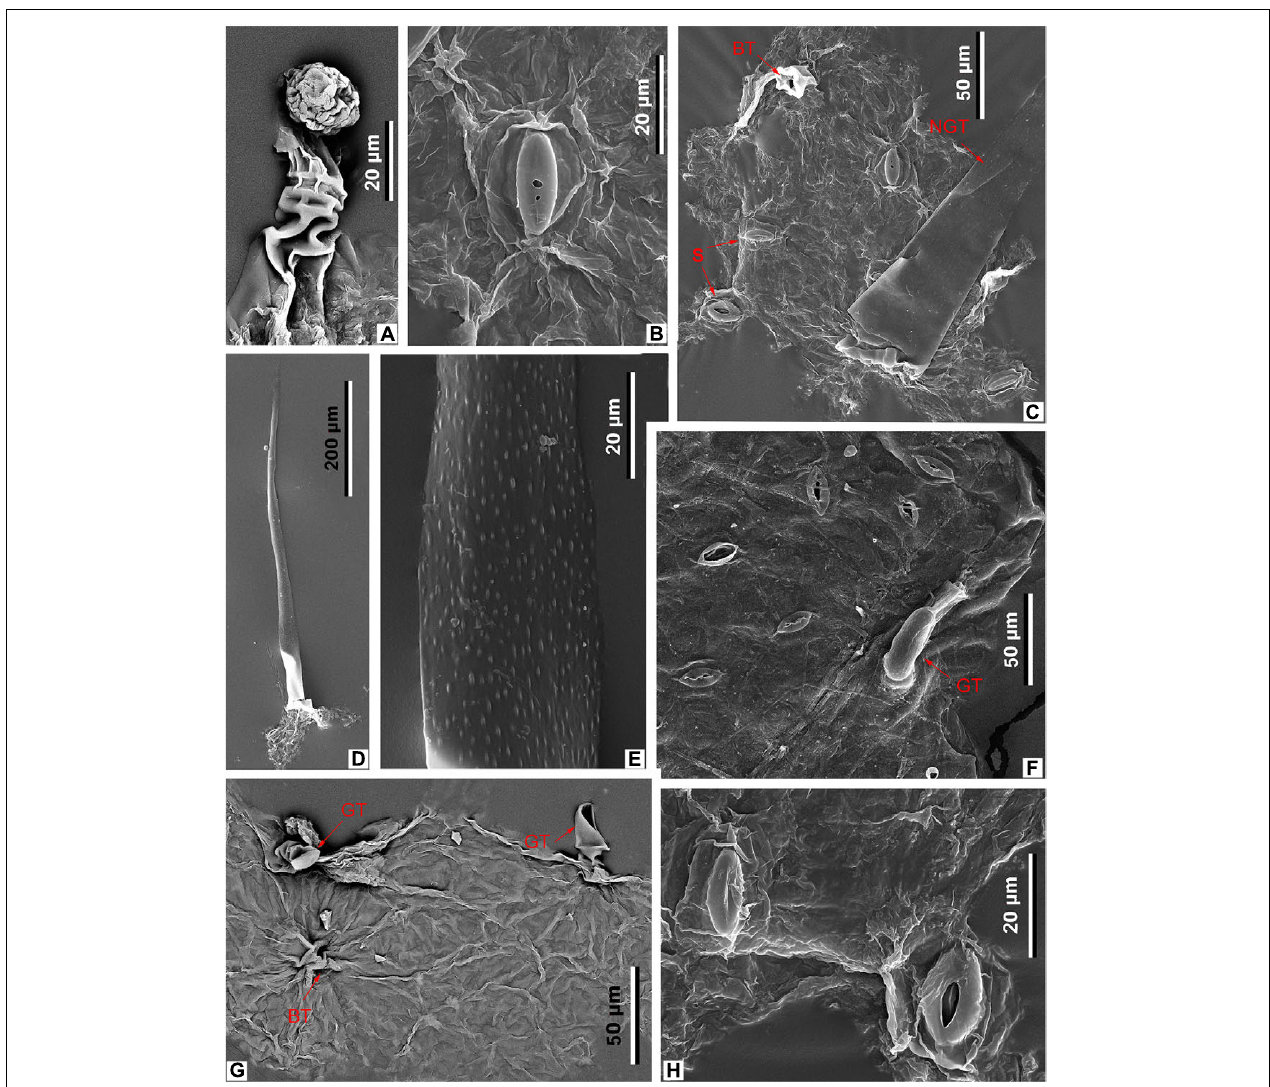
FIGURE 9 | Leaf epidermal characters of M. eosinica sp. nov., MMJ3-837-3a (A–E,G,H) , and extant M. simplicifolia (Roxb.) Walp., SYS00085373 (F) , SEM. (A) Glandular trichome. (B) Stoma. (C) Abaxial surface with stomata (S), unicellular non-glandular trichome (NGT), and base of glandular(?) trichome (BT), external view. (D) Abaxial surface with long unicellular non-glandular trichome. (E) The surface of non-glandular trichome (NGT). (F) Abaxial surface with stomata (S) and glandular trichome (GT), external view. (G) Adaxial surface with glandular trichomes (GT), internal view. (H) Abaxial surface with two stomata, external